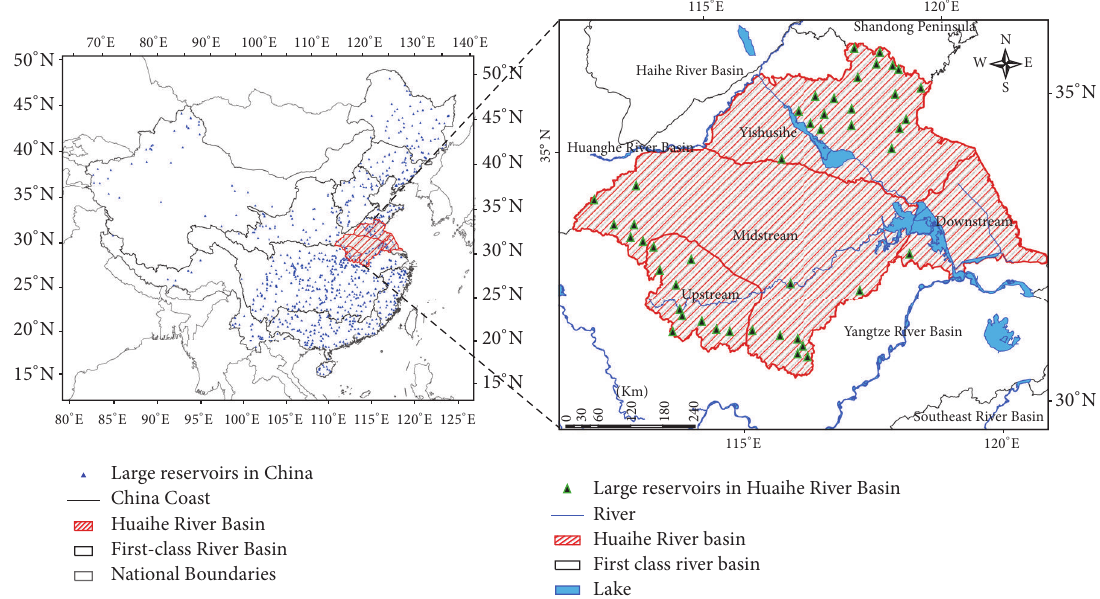
Figure 16: Map of large reservoir distribution in Huai River Basin.